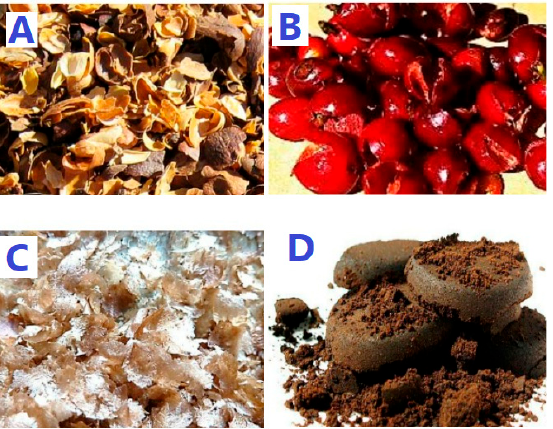
Figure 1. Pictorial view of ( A ) Coffee husk (CH), ( B ) coffee pulp (CP), ( C ) coffee silverskin (CSS). and ( D ) spent ground coffee (SCG) Source: [6].